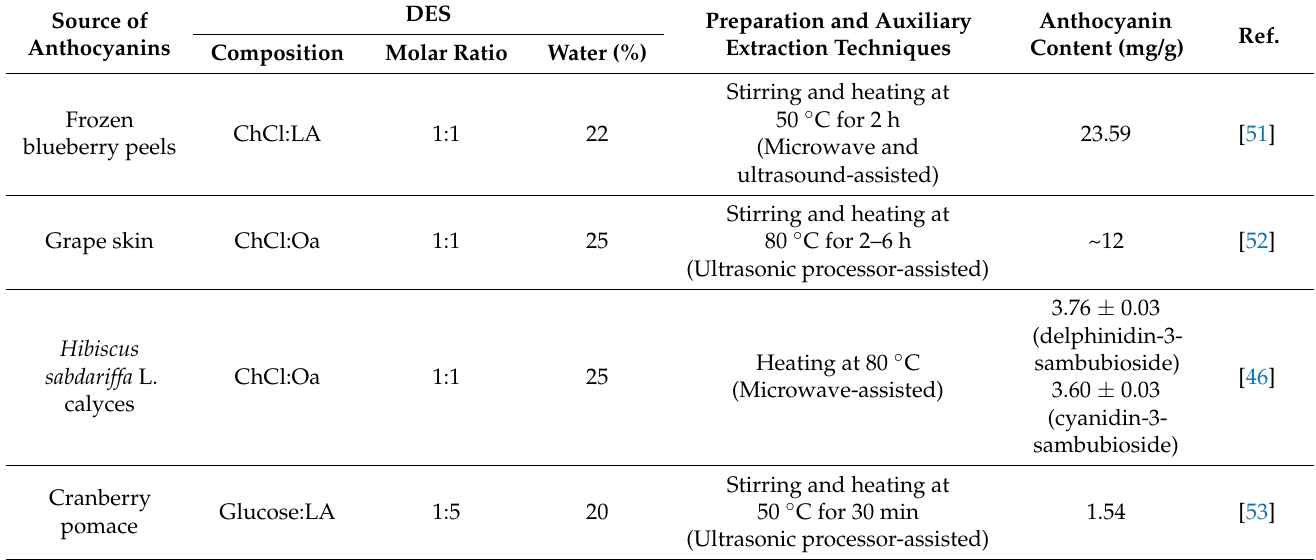
Table 1. Some examples of DES used for the extraction of anthocyanins and respective extraction yields (ChCl-choline chlorine; LA-lactic acid; Oa-Oxalic acid; Pro-Propylene glycol; TA-tartaric acid; CA-citric acid; MA-malic acid; gly-glycerol; Eg-Ethylene